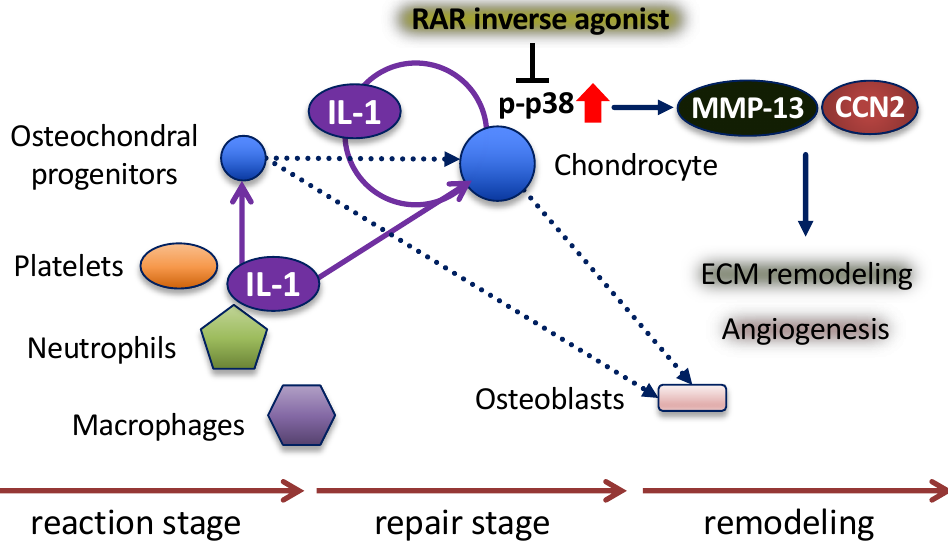
Figure 7. The expression and roles of IL-1β and RAR inverse agonists on endochondral bone ossification during fracture healing. Fracture healing can be viewed as a three-stage process. In the early fracture processes, platelets, neutrophils and macrophages secrete IL-1. Osteochondral progenitors differentiate into chondrocytes that proliferate to generate the early soft callus. Dotted line arrow: cell differentiation. Hypertrophic chondrocytes in the mature callus express angiogenic factors that result in vascular invasion. IL-1 induces the expressions of MMP-13 and CCN2 from chondrocytes via p38 MAPK, which is common with the RAR signal, suggesting that IL-1 plays an important role in ECM remodeling and angiogenesis (arrows).